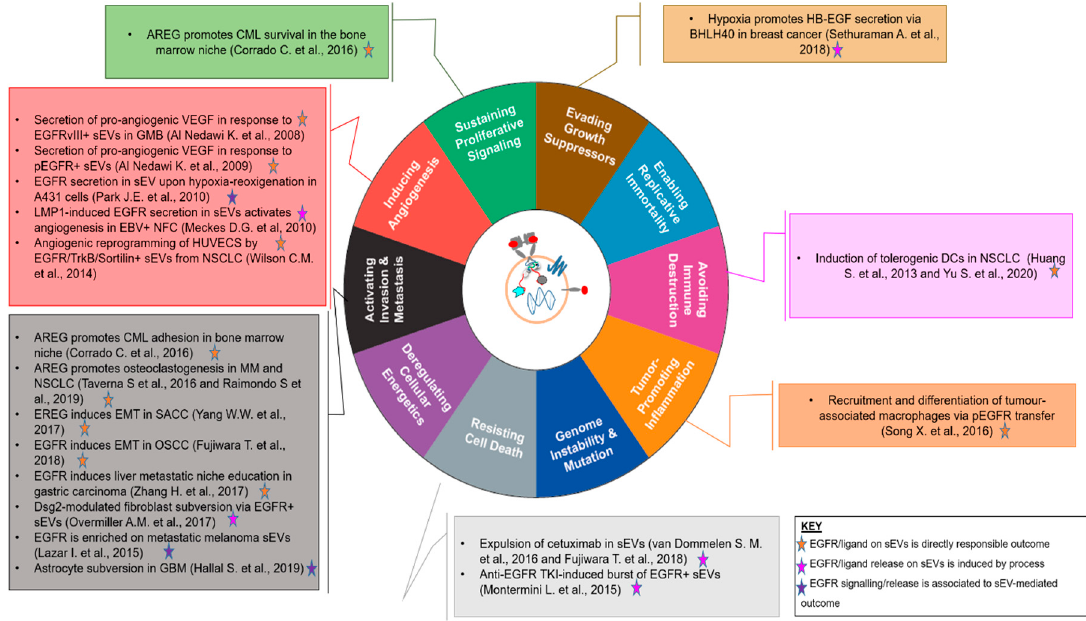
Figure 3. An EGFR-centric view of the involvement of EVs in the Hallmarks of Cancer [97], summarising the key findings for the role of EGFR + /Ligand + EVs in the “achievement” of each. The central cartoon schematically depicts a sEV displaying EGFR, a full-length transmembrane EGFR family ligand, a tetraspanin marker and nucleotidic cargo. Findings are denoted by first author and year and colour-coded according to the role played by EGFR and/or its ligands in the biological outcome referenced.